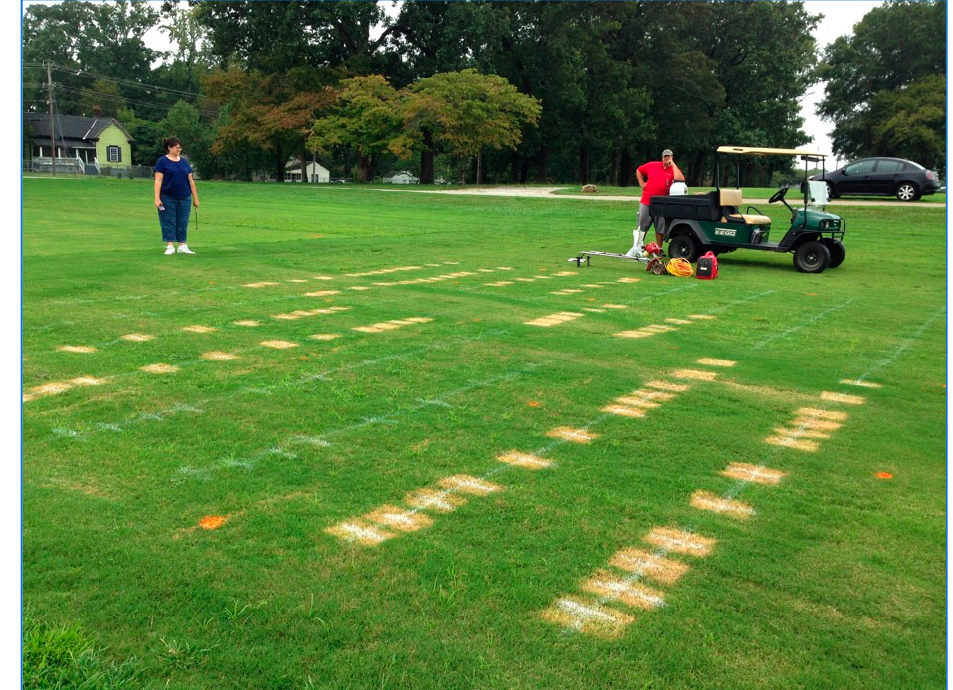
Figure 2. Glyphosate treated field ready to plant in 2014.